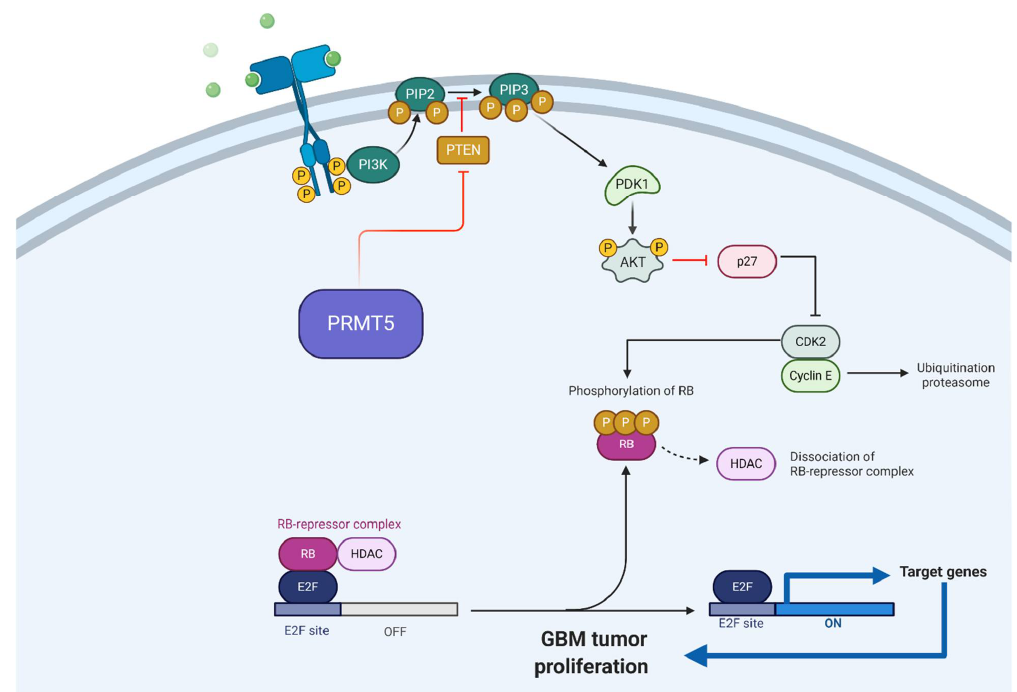
Figure 3. Schematic drawing of PRMT5-PTEN axis. Akt = Protein kinase B; CDK2 = Cyclin-dependent kinase 2; GBM = Glioblastoma; HDAC = Histone deacetylase; PIP2 = Phosphatidylinositol (4,5)-bisphosphate; PIP3 = Phosphatidylinositol (3,4,5)-triphosphate; P = Phosphorous; PTEN = Phosphatase and tensin homolog; PI3K = Phosphoinositide-3-kinase; PRMT5 = Protein arginine methyltransferase 5; RB = Retinoblastoma. Adapted from “G1/S Checkpoint”, by BioRender.com (2020). Retrieved from https://app.biorender.com/biorender-templates.